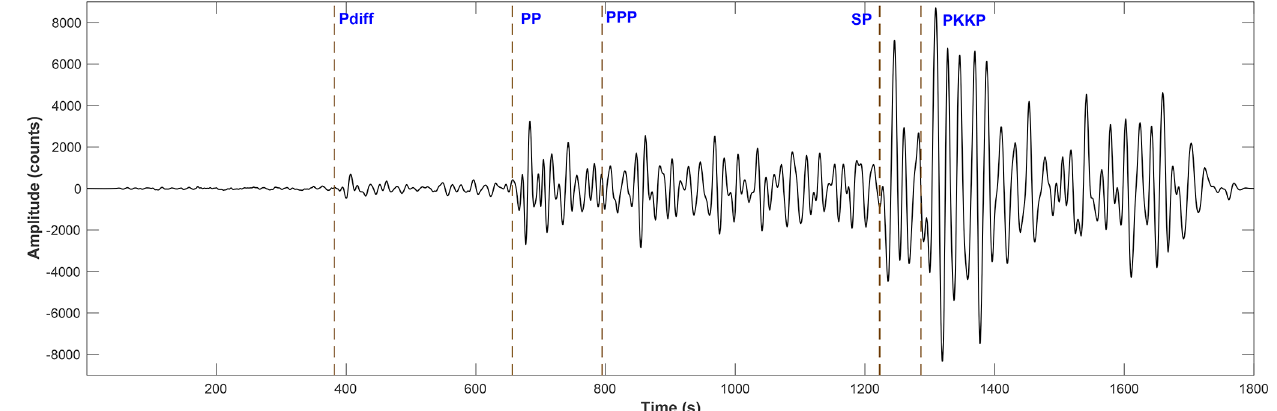
Figure 8. Filtered seismic waveform showing some of the seismic phases visible from the 28 September 2018 Palu, Indonesia, earthquake. The vertical-component waveform is bandpass filtered between 0.01 and 0.1Hz to isolate the signals of interest. The earthquake occurred at a depth of 20km and was ∼ 12200km from the recording station (GT01) in the Wills Memorial Building (source USGS, 2018).